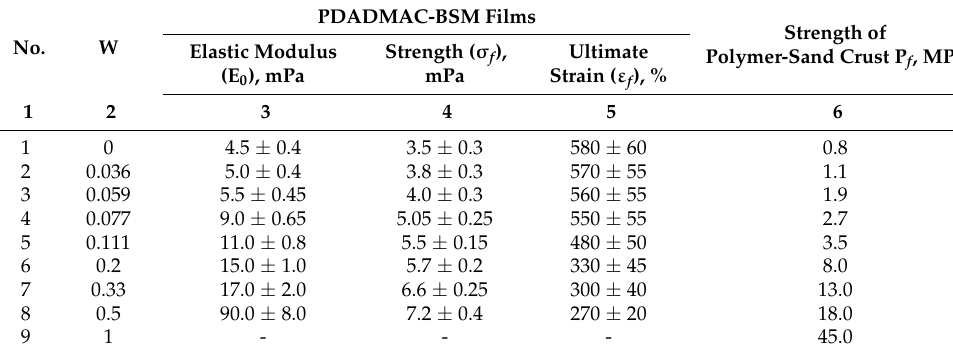
Figure 2. Stress–strain diagrams for the films prepared from BSL (W = 0) (1) and BSMs–PDADMAC mixtures with W = 0.077 (4), 0.111 (5), 0.2 (6), 0.333 (7) and 0.5 (8). Numbers at the curves correspond to the sample numbers in Table 1. Table 1. Mechanical properties of BSMs–PDADMAC films and polymer-sand crusts with different PDADMAC content W.